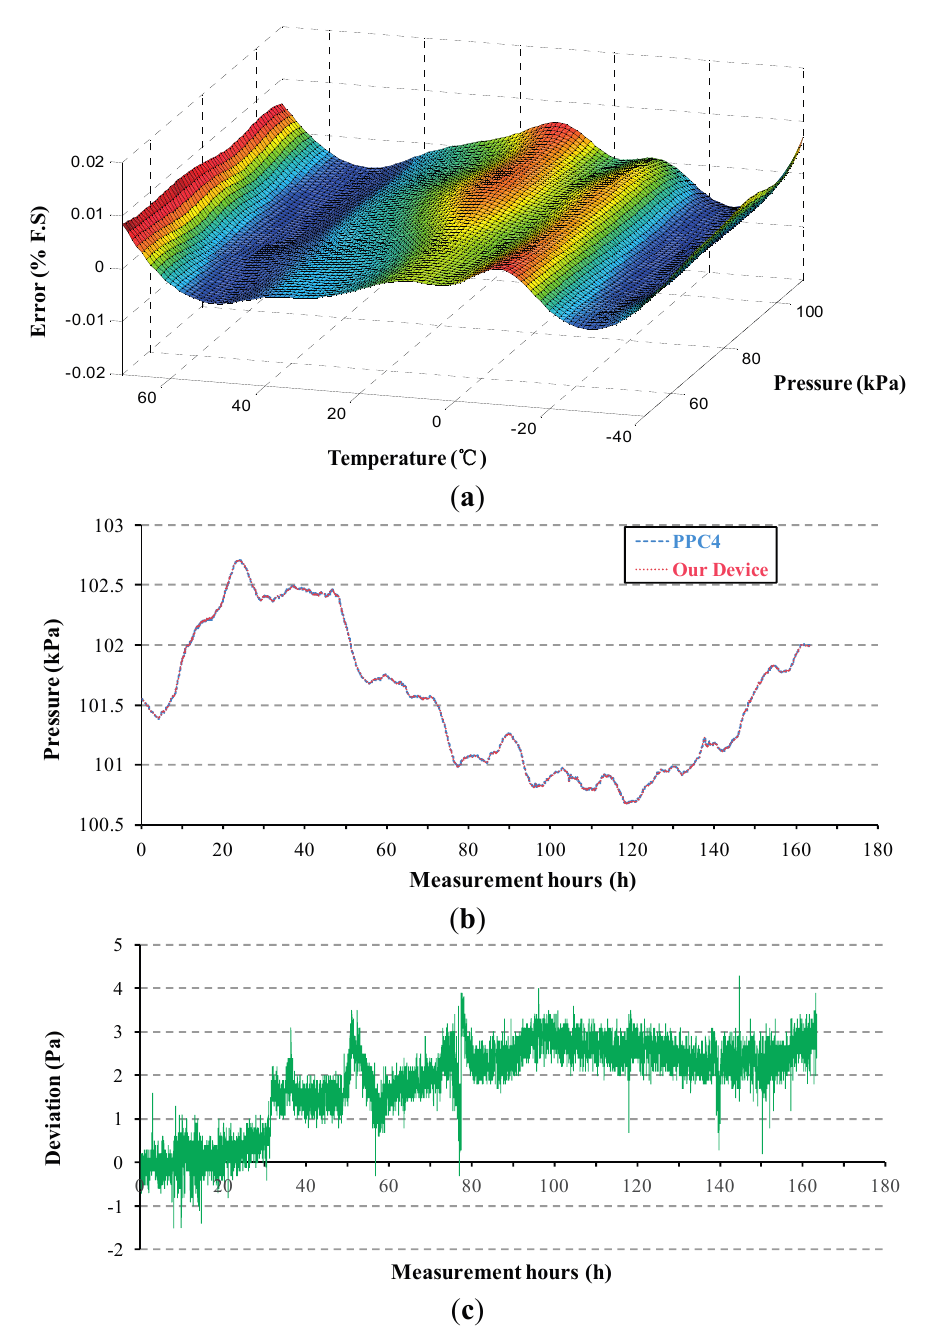
Figure 8. ( a ) Curve-fit accuracy, better than <0.01% of Full Scale; ( b ) Actual atmospheric pressure measurement of the device proposed in this study and PPC4 over a 7-day period, with pressure deviations shown in ( c